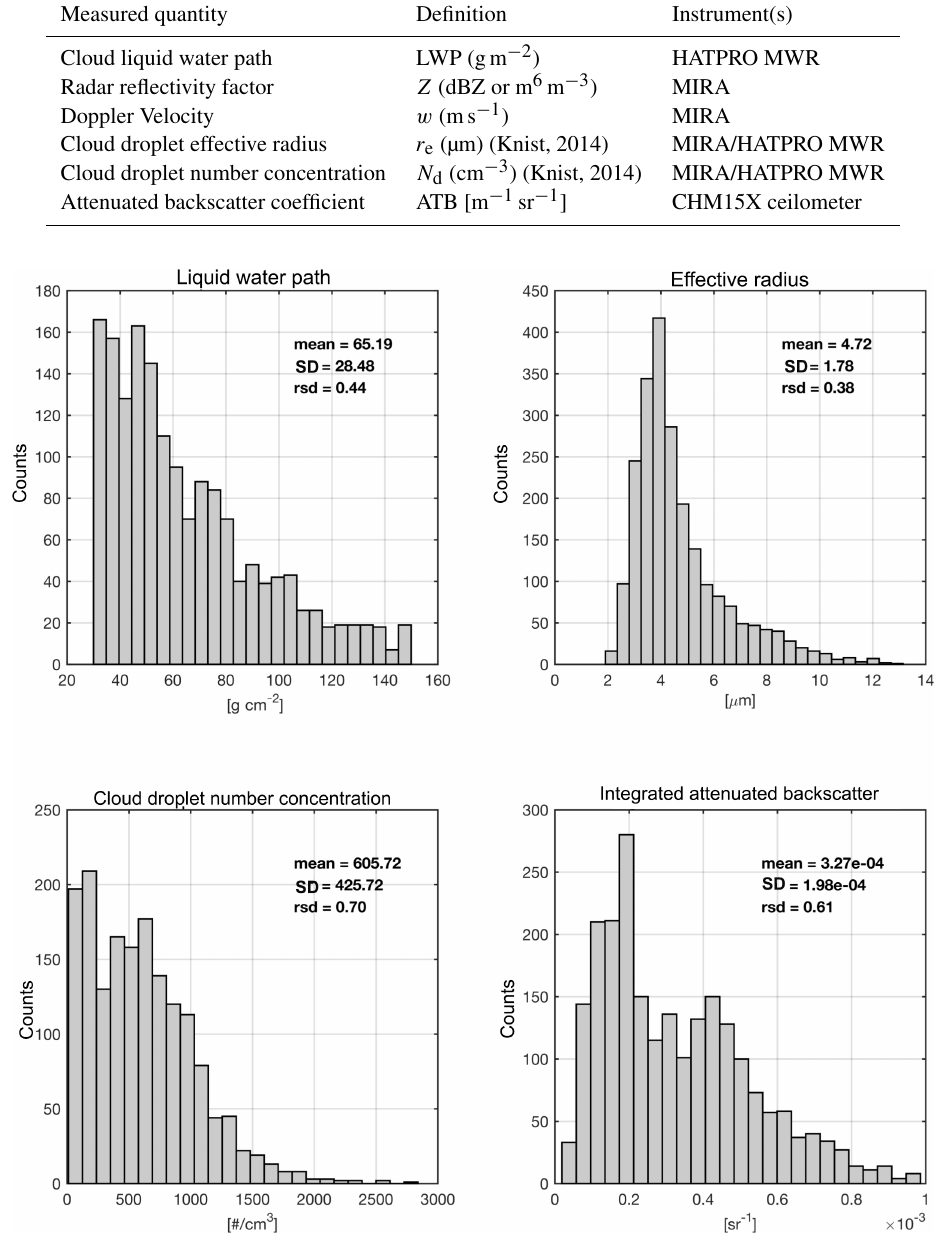
Figure 1. Histograms of the measurements and retrievals for the aggregated data